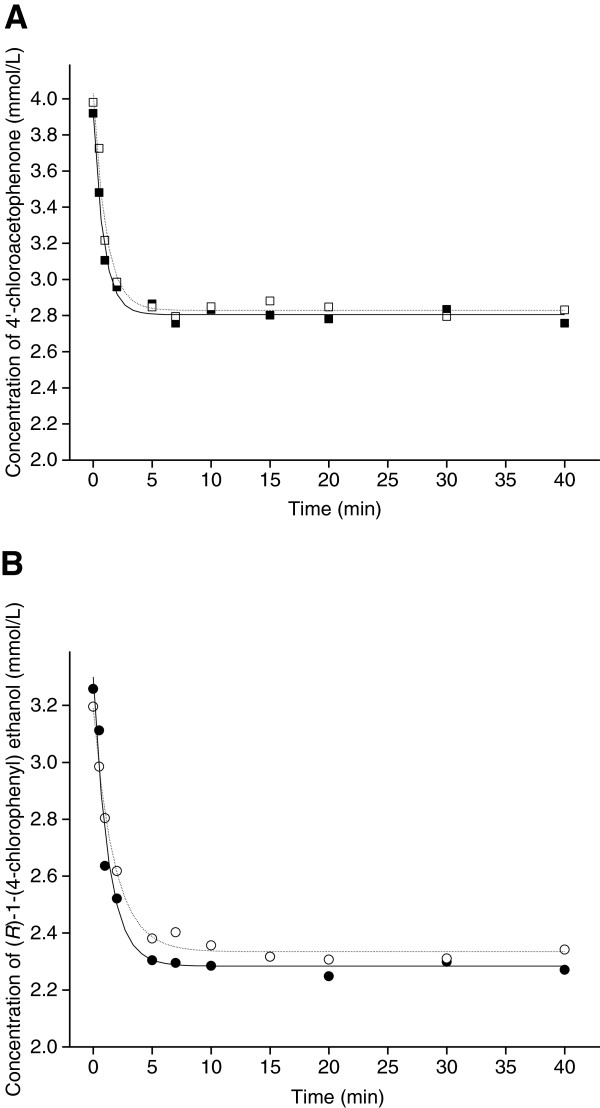
Mass transfer of 4′-chloroacetophenone (A) and (R)-1-(4-chlorophenyl)ethanol (B). From bulk solution into Ca-alginate (open symbols) and alginate-chitosan beads (solid symbols). Symbols represent observed concentrations obtained from experiments. Curves represent predicted concentrations from the best fit of equation (2) for these experimental data.